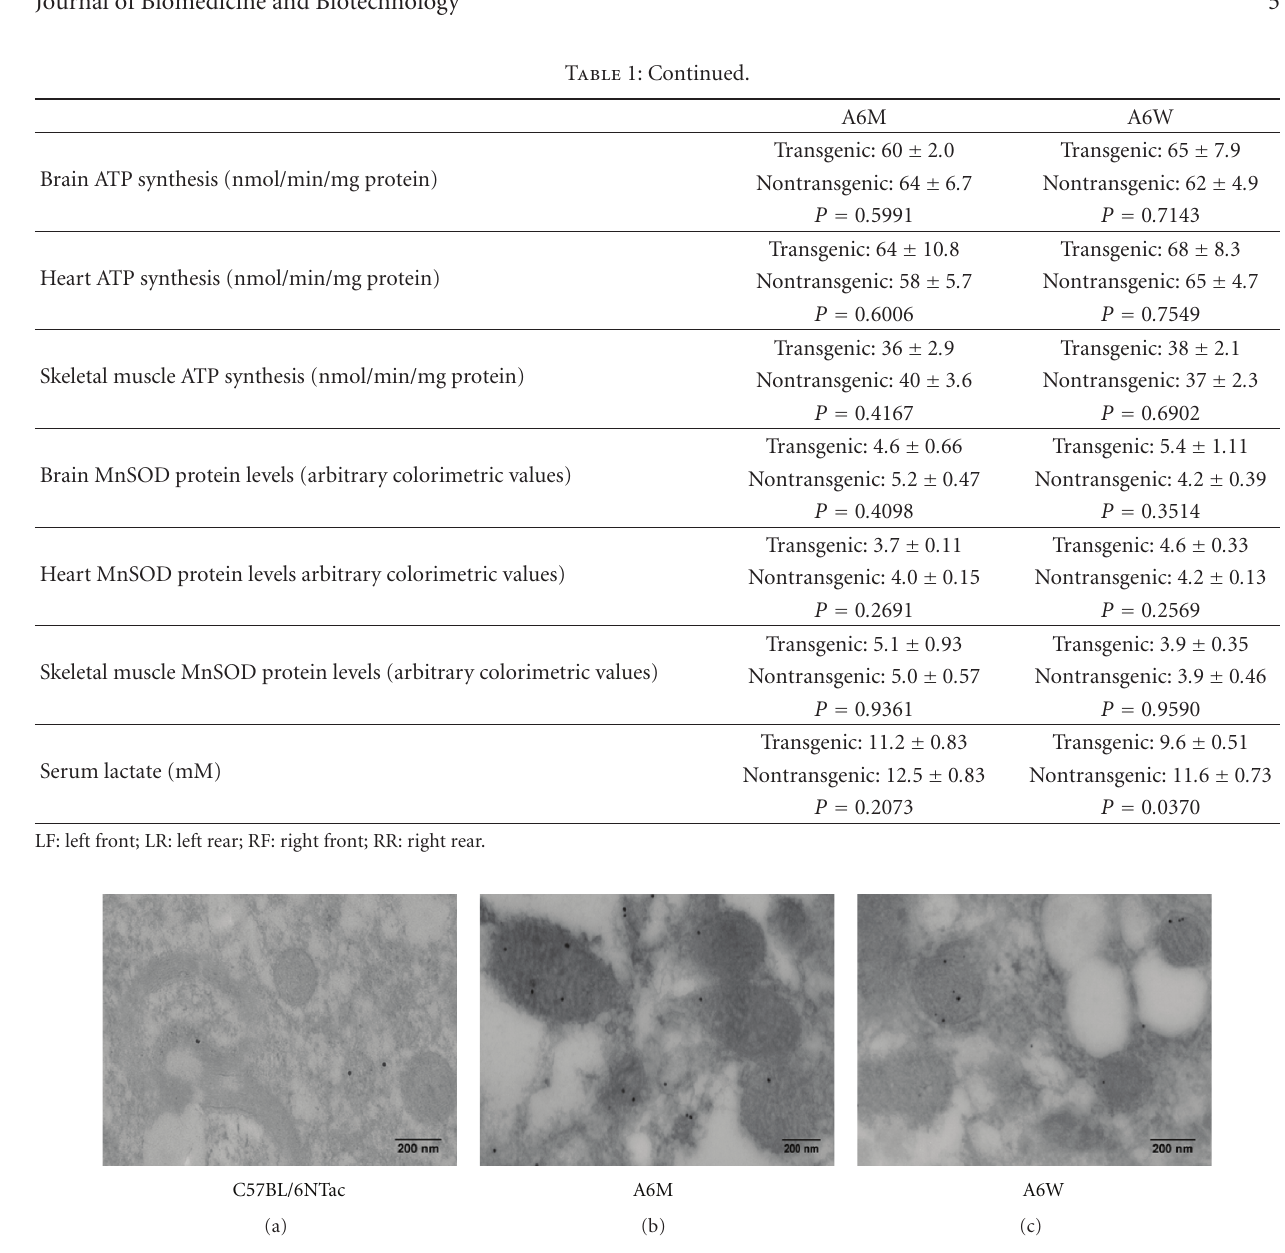
Figure 2: Mitochondrial localization of allotopically expressed ATP6 in brain sections of nontransgenic, A6M and A6W mice. The small amount of cytosolic nonmitochondrial staining is not unexpected as proteins are cytoplasmically translated prior to mitochondrial